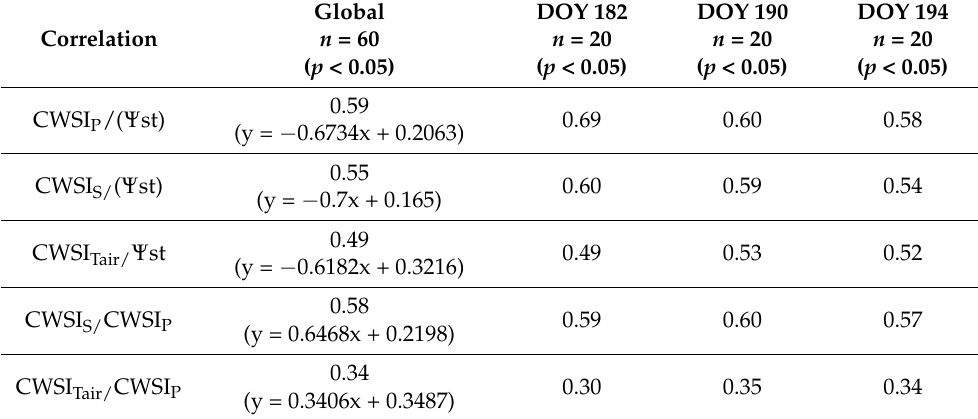
Table 5. Determination coefficients (R 2 ) of the different CWSI S and the stem water potential ( Ψ st).